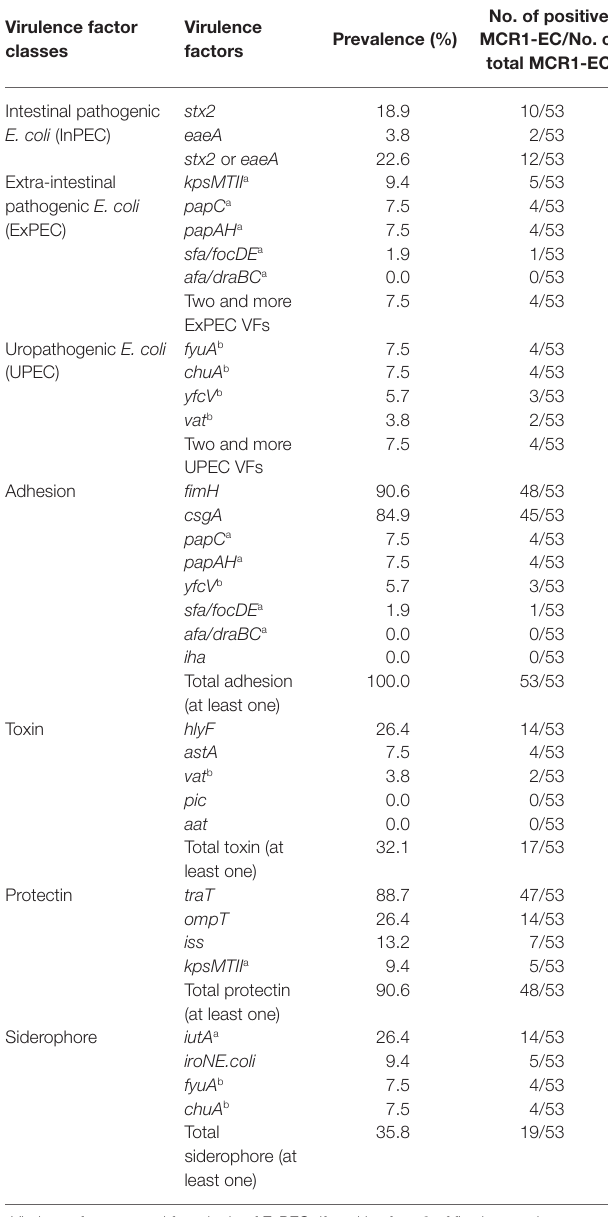
TABLE 2 | Analysis of pathogenic E. coli -associated virulence factors in MCR1- EC from swine farms. Virulence factor Virulence classes